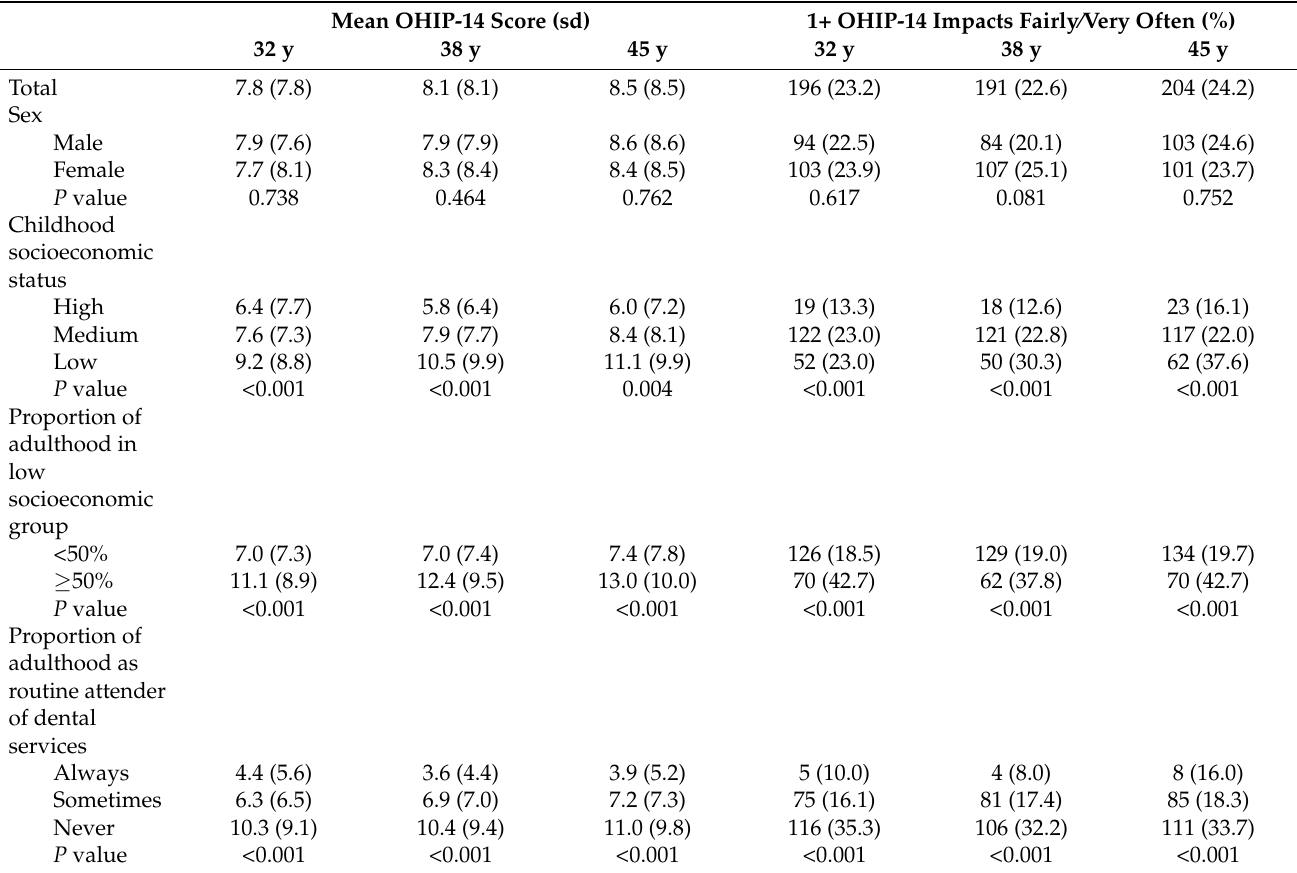
Table 1. Mean oral health impact profile (OHIP-14) scores and impact prevalence at ages 32, 38, and 45 years by participant socio-demographic